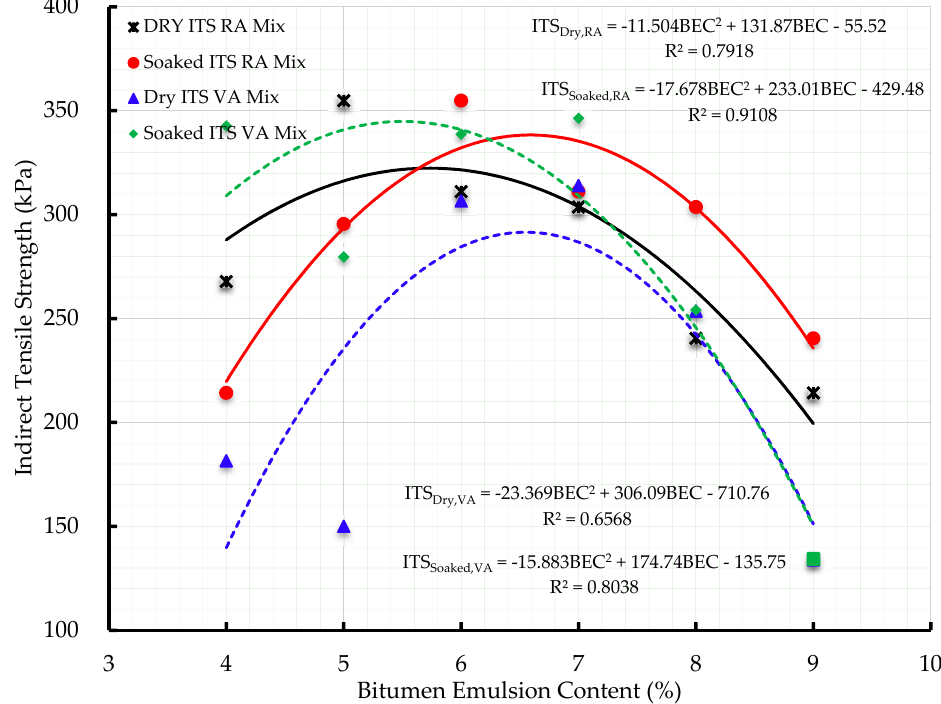
Figure 6. Indirect Tensile Strength for Virgin Aggregates and Reclaimed Asphalt Aggregates Mixes at Optimum Bitumen Emulsion